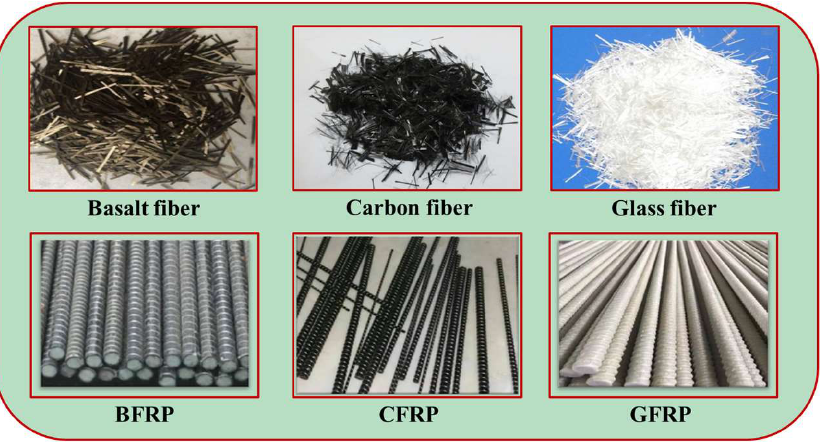
Figure 7. The types of inorganic fiber and fiber-reinforced polymer.